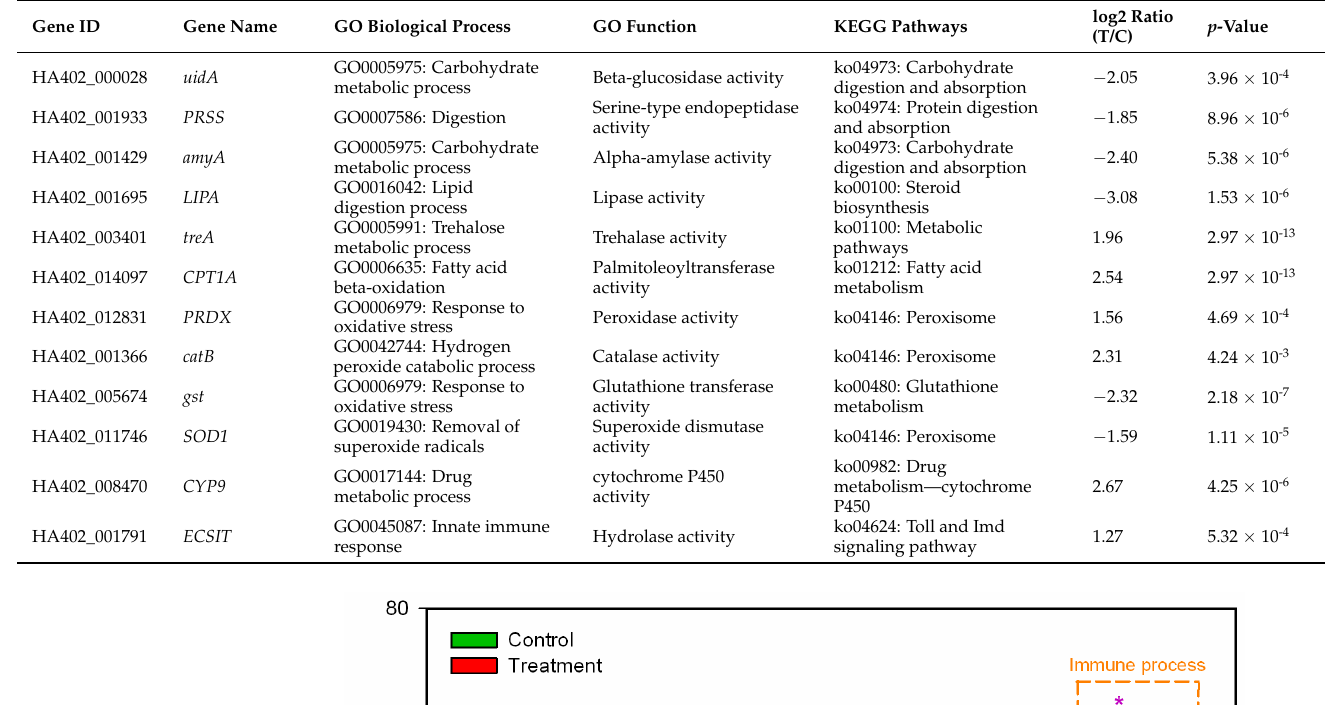
Table 3. Differently expressed genes of B. odoriphaga larvae infected by M. hiemalis BO-1 by transcrip- tome analysis. Figure 4. GO term enrichment analysis for the DEGs and the distribution of pathways annotated in the Kyoto Encyclopedia of Genes and Genomes (KEGG) data library in B. odoriphaga larvae after infection with M. hiemalis spores.